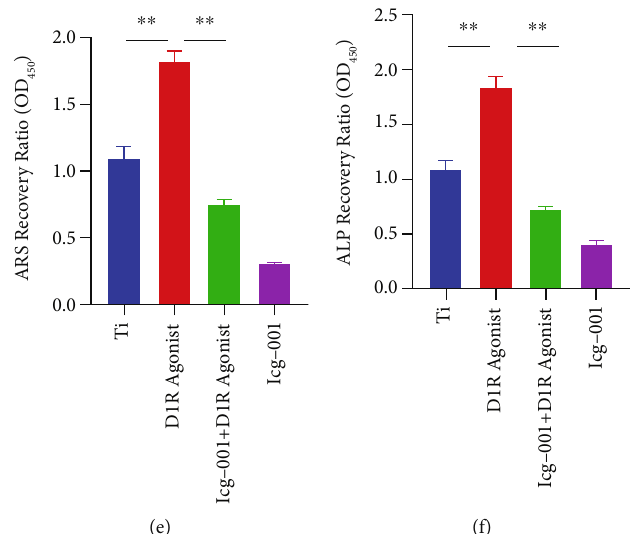
Figure 5: D1R upregulation attenuates titanium particle-induced osteogenic inhibition by activating the Wnt signaling pathway in vitro . (a) Representative images of western blots probed with antibodies against OSX and Runx2 in the presence of a Wnt pathway inhibitor (icg-001). (b-c) Quanti fi cation of OSX and Runx2 protein levels. n = 3 per group. NS: Not statistically signi fi cant, ∗ P < 0 : 05 , ∗∗ P < 0 : 01 , vs. titanium particle inducer group (without treatment with D1R agonists and/or icg-001). (d) Representative images of ALP and ARS staining in vitro . (e-f) Quantitative analysis of ALP activity and bone mineralization in BMSC cells in each group. Note: n = 3 per group; ∗ P < 0 : 05 , ∗∗ P < 0 : 01 compared with the titanium particle inducer group (without treatment with D1R agonists and/or